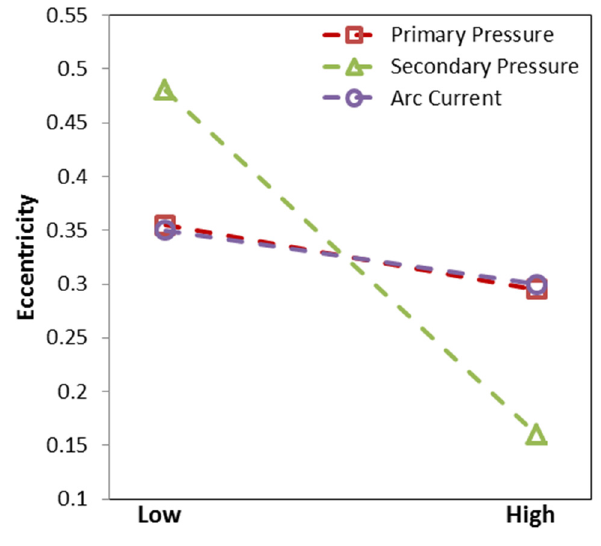
Figure 6. Effect of primary gas pressure, secondary gas pressure, and arc current on pattern eccentricity. A more elliptical pattern has a large eccentricity. Dashed lines not meant to imply a linear